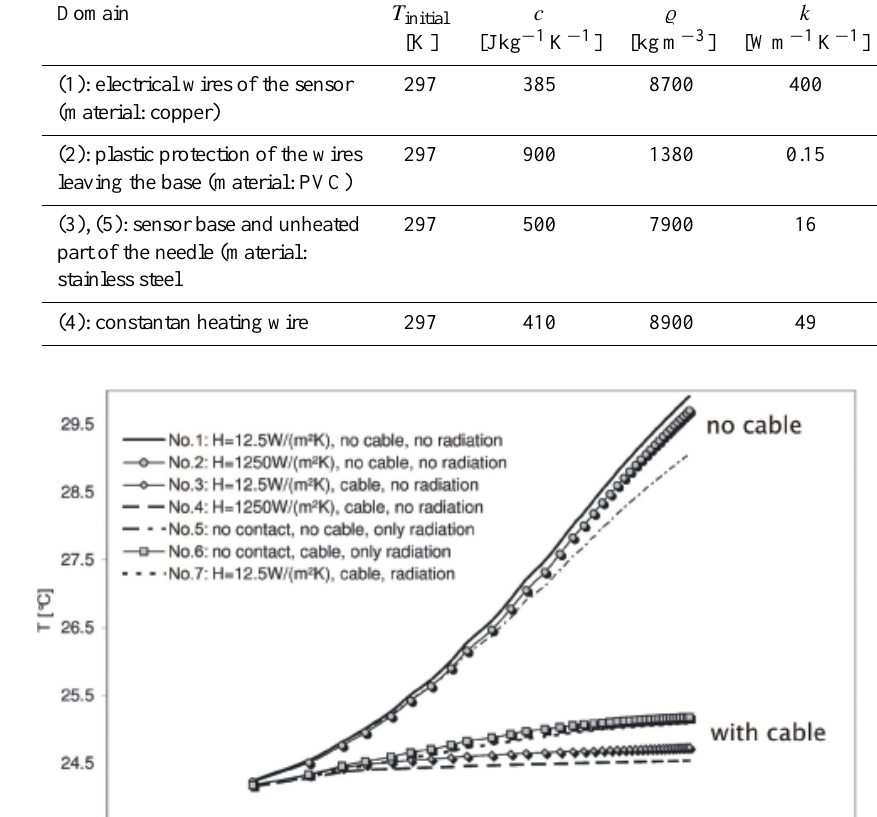
Table 6. Parameters used for the different domains of the LNP03-model.